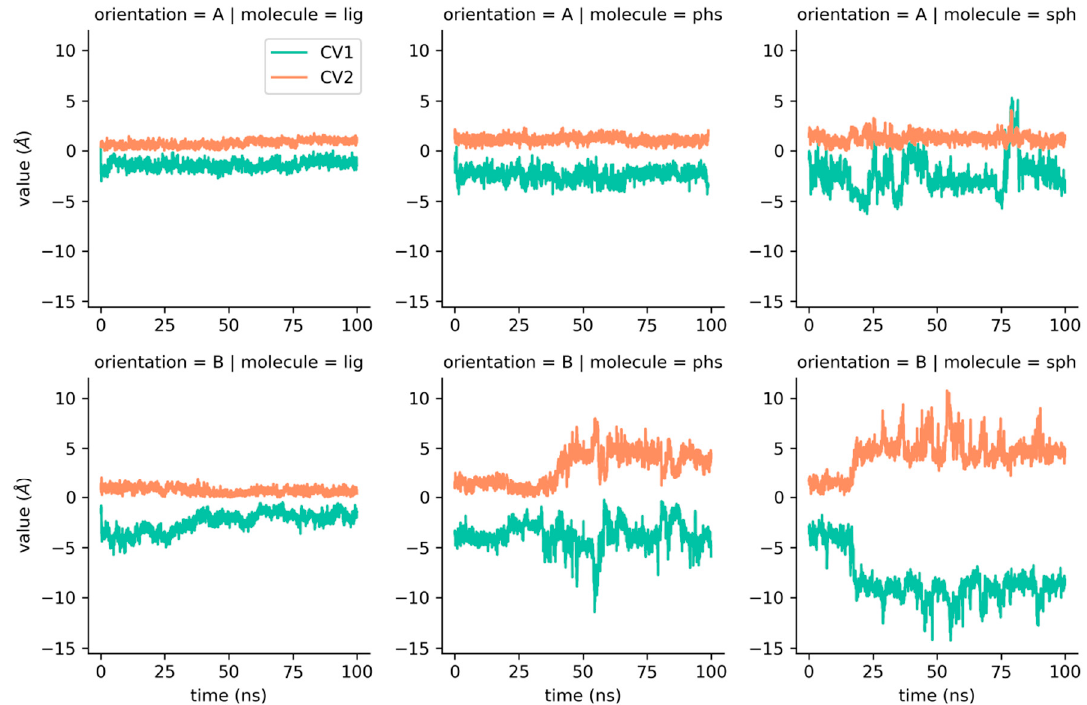
Figure 4. CV1 and CV2 along the unbiased molecular dynamics trajectory for the three ligands in orientations A and B calculated only for aliphatic carbons. “Lig” = natural ligand of Pru p 3, “phs” = phytosphingosine, and “sph” =